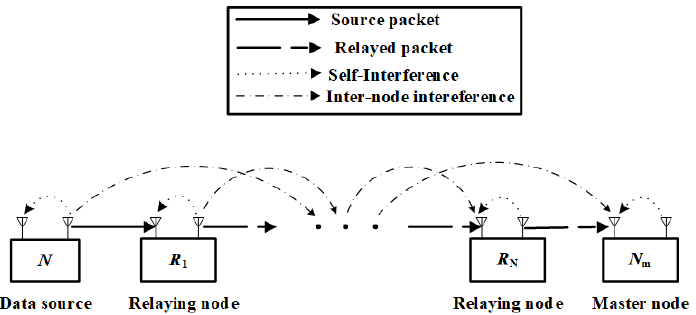
Figure 2. Multi-hop chain FDR